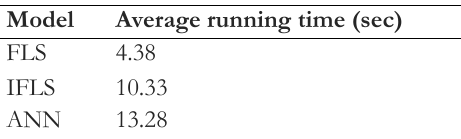
Table 8. Comparison of running time of FLS, IFLS and